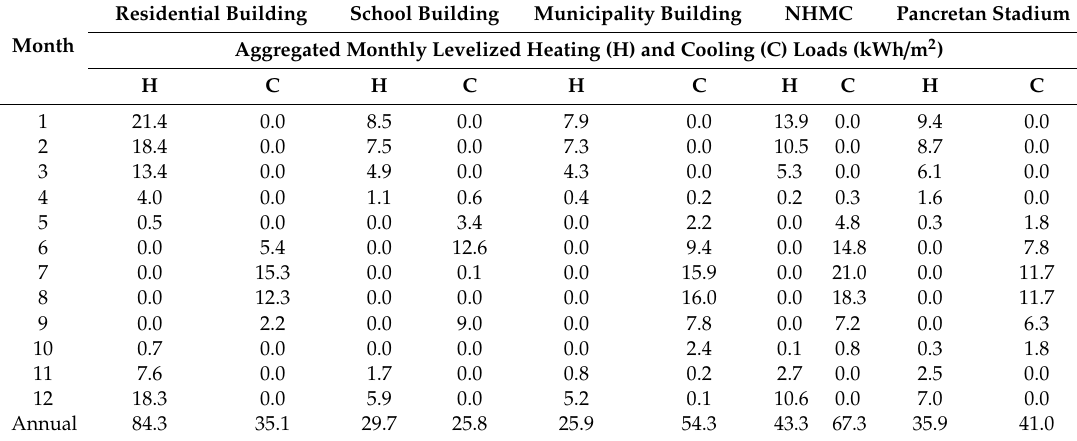
Table 3. Heating and cooling loads monthly analysis, levelized per m 2 of indoor conditioned space, for the examined building in the existing